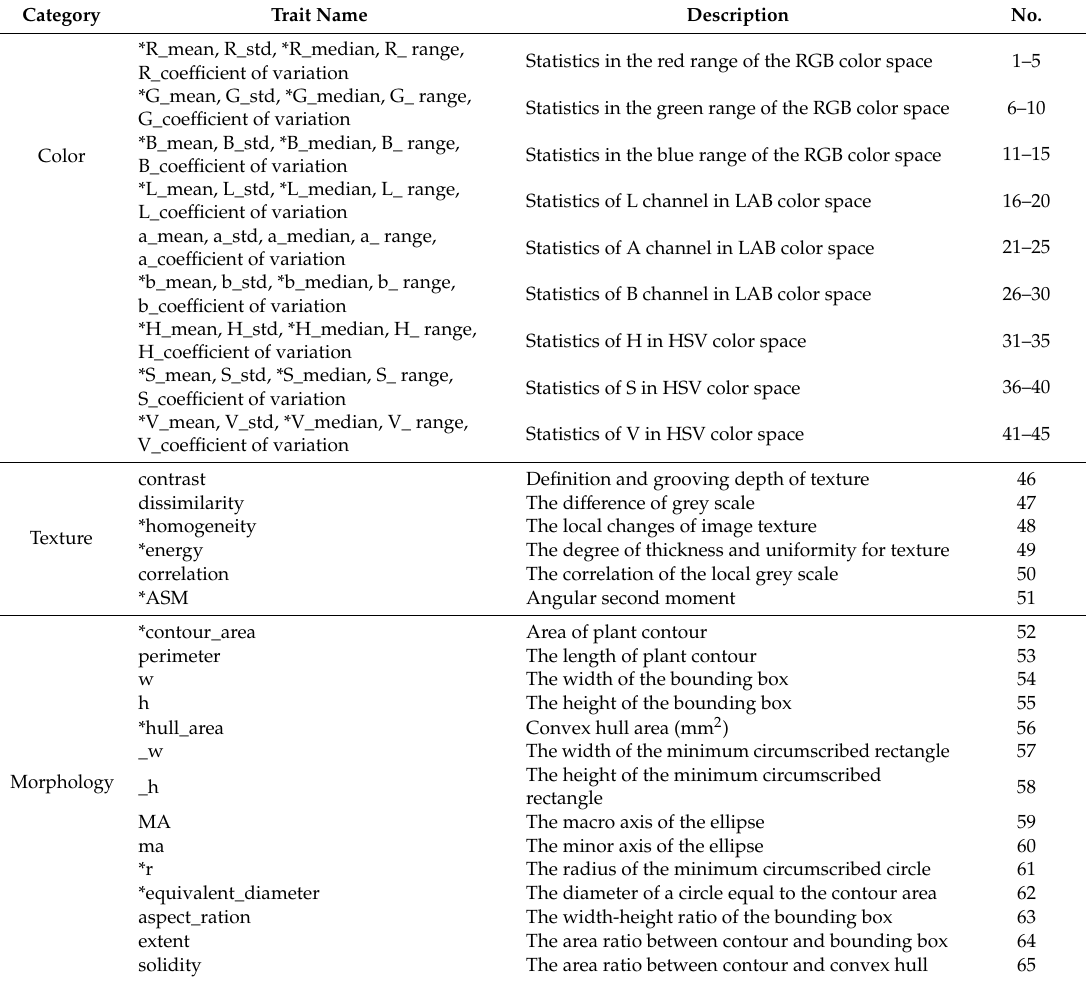
Figure 3. The pakchoi images at different growth periods (0, 7, 14, 21, 28, 35, and 42 days after the first N application, respectively). Table 1. Phenotypic features extracted from images in